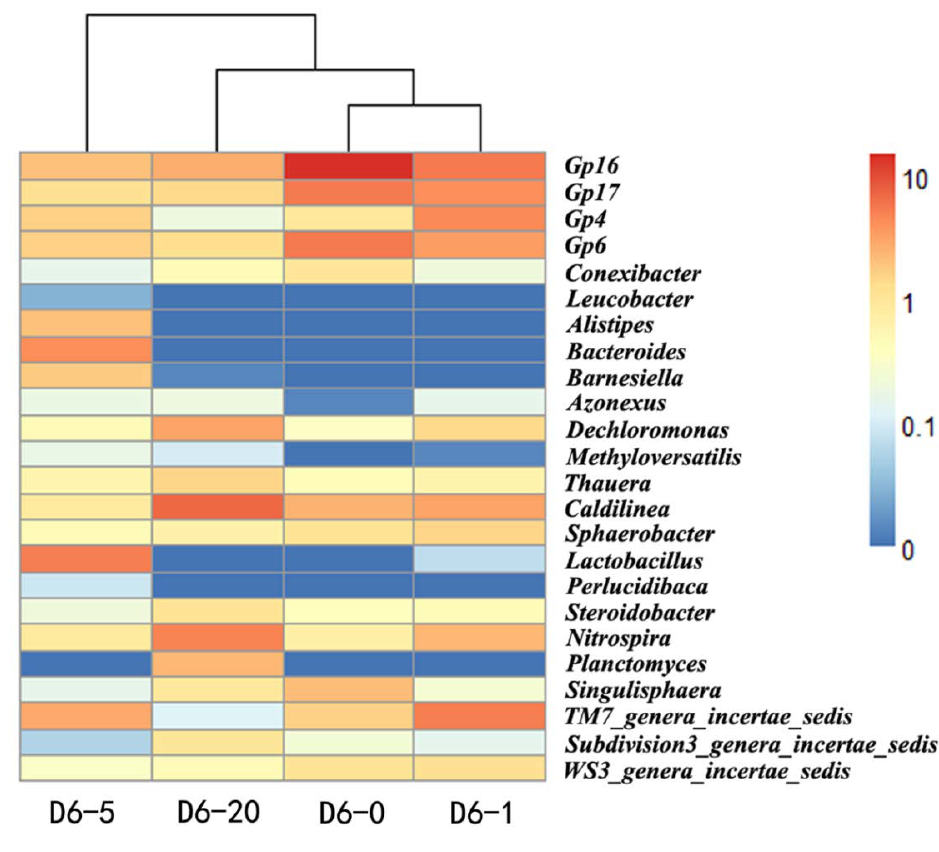
Figure 2. Heat map of genera occurring at >1% abundance in at least one sludge sample. Scale bar on the right shows the variation of the normalized abundance of the genera. D6-0, D6-1, D6-5 and D6-20: sludge cultured with 0, 1, 5 and 20 mg/L tetracycline for 6 days,